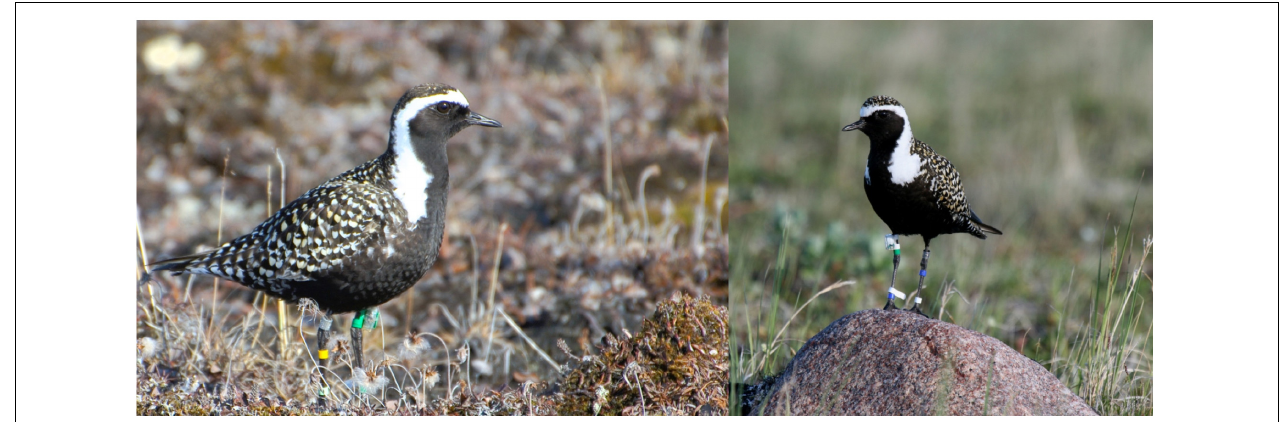
FIGURE 2 | Breeding American Golden-Plover ( Pluvialis dominica ) equipped with leg bands and a geolocator (left tibia). Photo by Andréanne Beardsell (left) and FS (right)